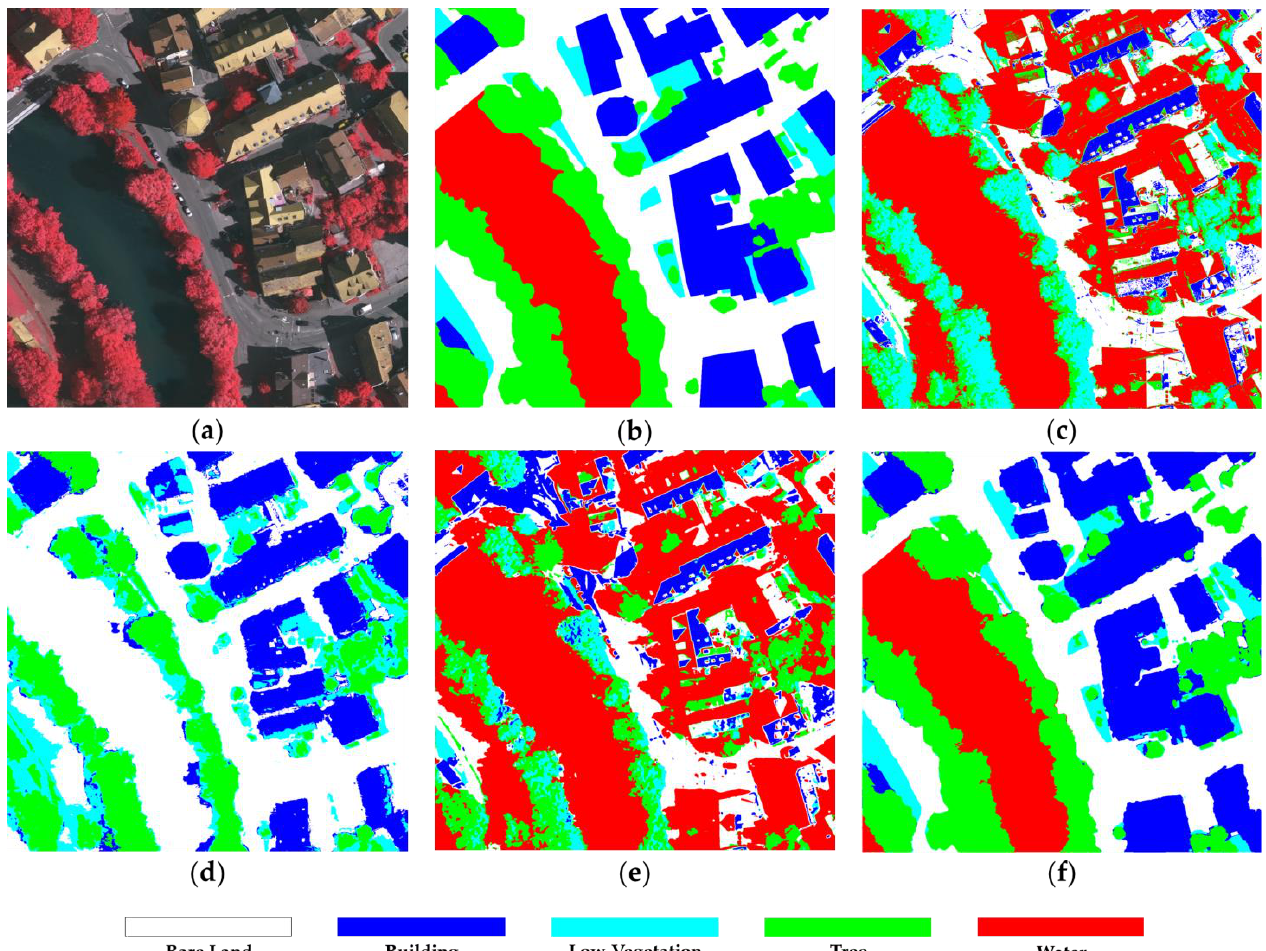
Figure 5. Clustering maps of the Vaihingen dataset. ( a ) The true color composite, ( b ) the ground truth map, ( c ) MS, ( d ) MDN, ( e ) CAE – MS, and ( f ) BCAE. Table 11. A comparison between the clustering results of the Vaihingen dataset.